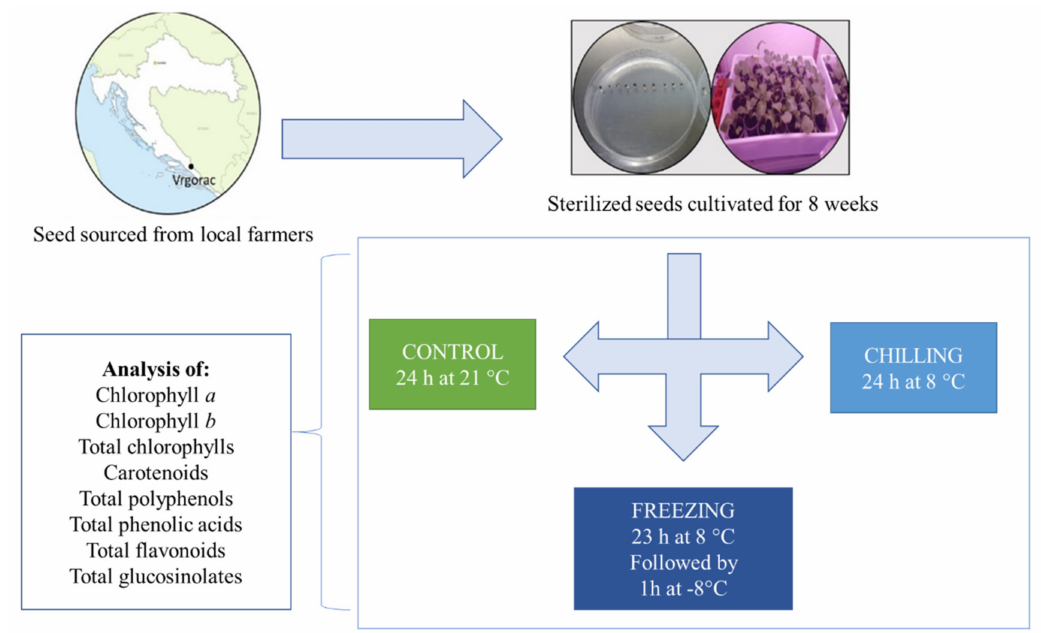
Figure 1. Schematic diagram of the short-term cold